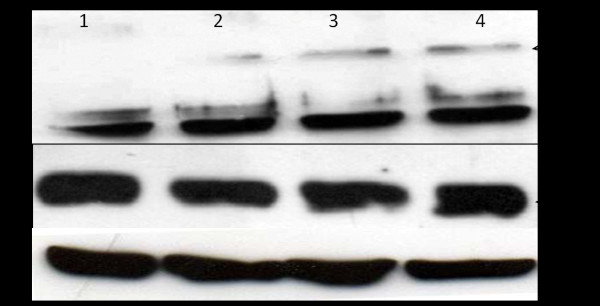
Immunoblot analysis of TJ proteins after treatment with MMPs. Occludin appears as a 65 KDa protein (a) and claudin-1 migrates as a 28 KDa band (b). lane 1 = control, no incubation, lane 2 = control, incubation for 1 h at 37°C, lane 3 = incubation with MMP2 for 1 h at 37°C, lane 4 = incubation with MMP9 for 1 h at 37°C. Equal amounts of protein were loaded to each lane (15 μg protein/lane). Antibody against β-actin was used to control the equal amounts of proteins in the lysates (c). No alteration to the tight junction proteins occludin and claudin-1 was observed after incubation with MMPs.